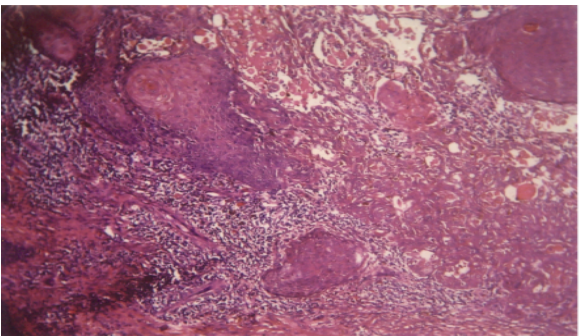
Figure 5: Biopsy specimen from the nodule showed anaplastic squamous epithelial cells in interconnected sheets and islands in the dermis. Well-defined keratin horn pearls are also demonstrated (Hematoxylin-Eosin Stain, x122)